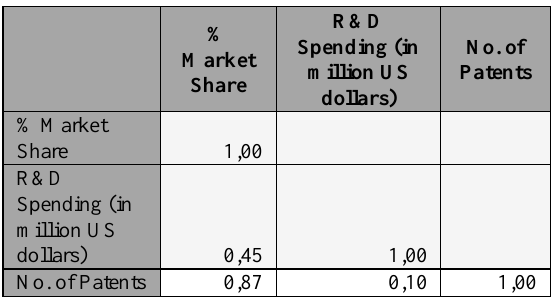
Table 5: Nokia Correlations of Variables